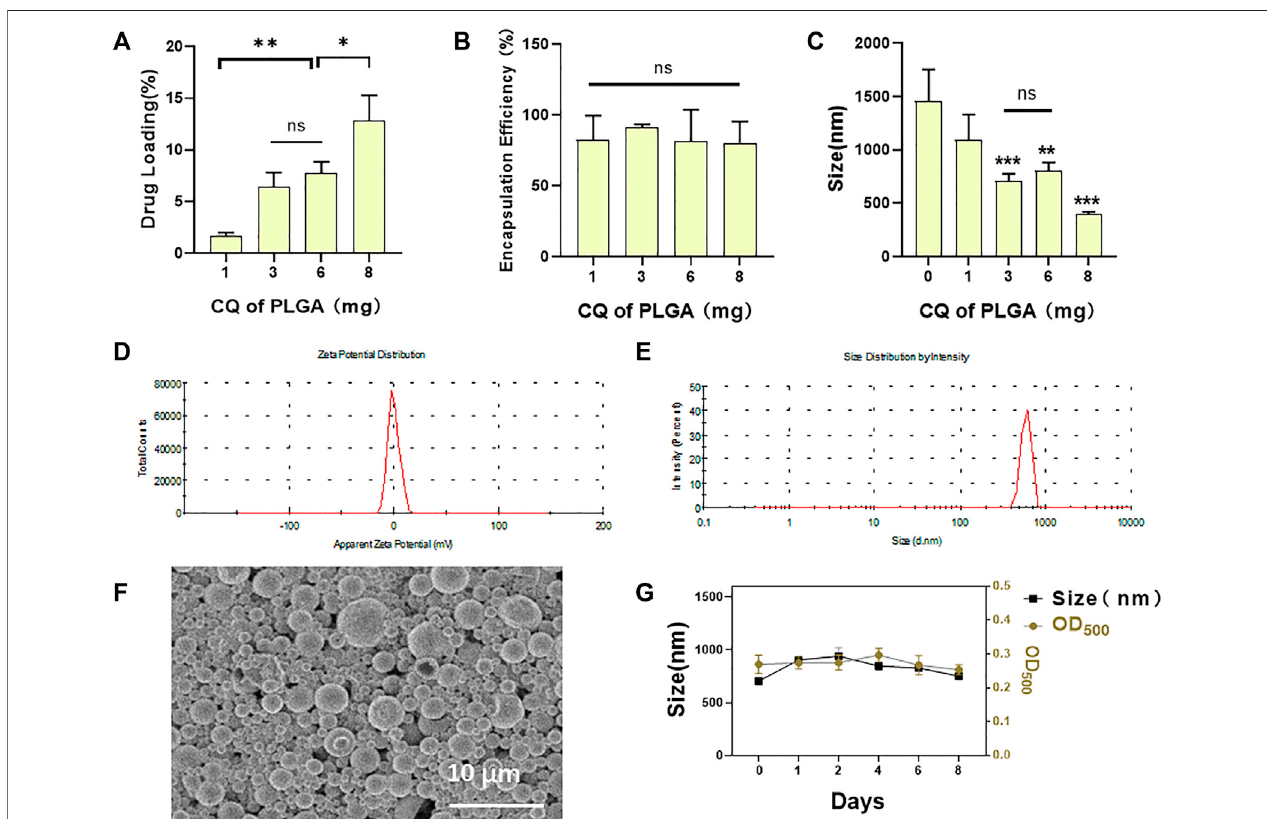
FIGURE2| CharacterizationofCQ/PLGA. (A) The drugloading ofCQ/PLGAprepared byadding 1-,3-,6-, and8-mgCQper 50-mgPLGA(comparisonbetween groups, * p < 0.05, ** p < 0.01). (B) The entrapment ef fi ciency of CQ/PLGA prepared by adding 1-, 3-, 6-, and 8-mg CQ per 50-mg PLGA. (C) Particle size distribution of CQ/PLGA prepared by adding 1-, 3-, 6-, and 8-mg CQ per 50-mg PLGA (vs. “ 0-mg group, ” ** p < 0.01, *** p < 0.001, n = 5). (D) The average particle size of CQ/PLGA MBs prepared by adding 6-mg CQ to 50-mg PLGA is 801.78 ± 69.10 nm. (E) The average potential of the particle size distribution of CQ/PLGA MBs prepared by adding 6-mg CQ to 50-mg PLGA is − 6.57 ± 0.15 mV. (F) CQ/PLGA nanoparticles were prepared by adding 6 mg CQ to every 50 mg PLGA. SEM micrographs of nanoparticles showing the shape and the surface characteristics of CQ/PLGA. (G) The particle size and concentration of porous lipid CQ/PLGA MBs were measured